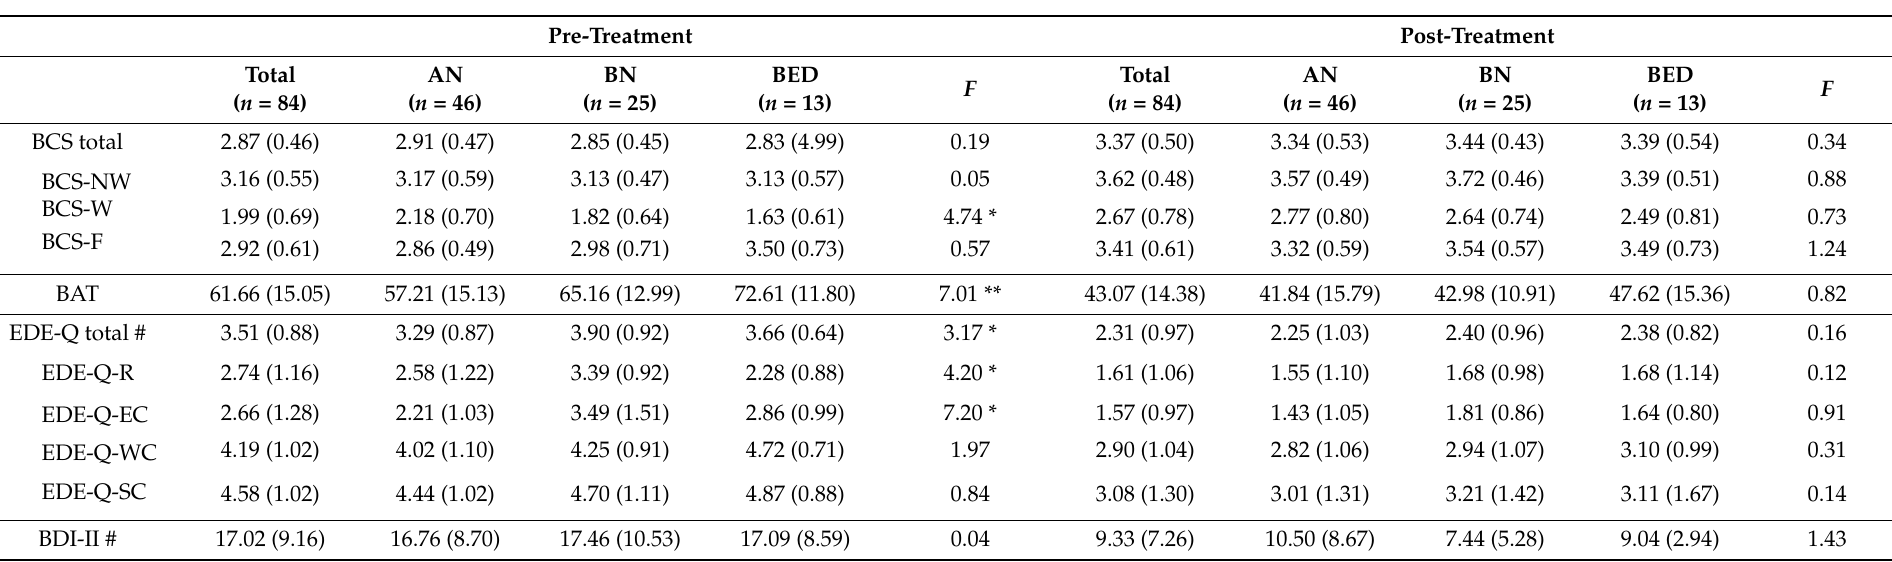
Table 2. Pre- and post-treatment outcomes and possible mediators for the total sample and the three diagnostic groups, with ANOVA results for the between-group